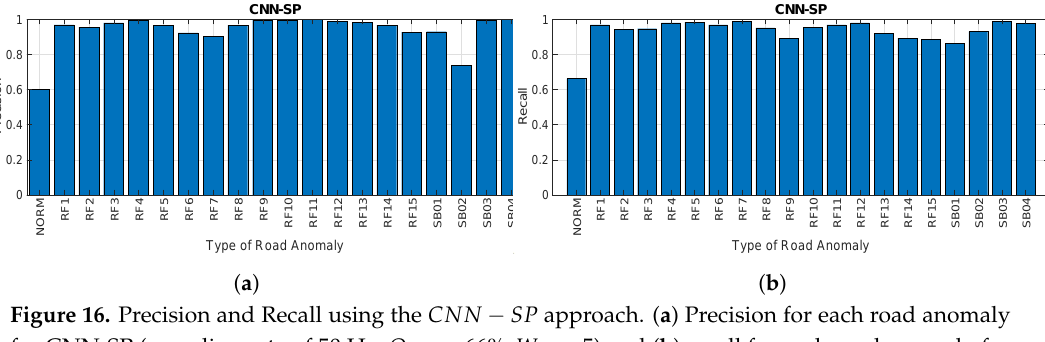
Figure 16. Precision and Recall using the CNN − SP approach. ( a ) Precision for each road anomaly for CNN-SP (sampling rate of 50 Hz, O lap = 66%, W R = 5) and ( b ) recall for each road anomaly for CNN-SP (sampling rate of 50 Hz, O lap = 66%, W R =